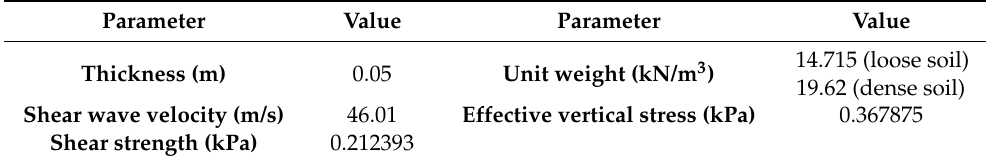
Table 4. Parameter of the DEEPSOIL used in this study.